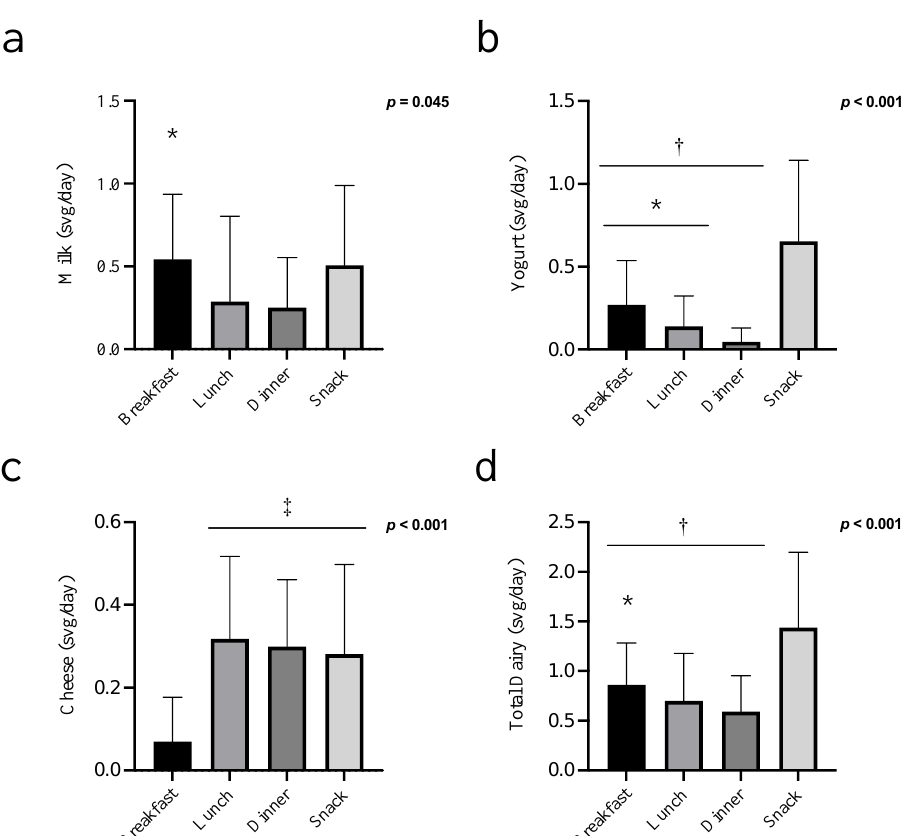
Figure 2. Dairy product consumption patterns in adolescent females in the recommended dairy product intake (RDa) group. Average number of svg/d of milk ( a ), yogurt ( b ), cheese ( c ), and total dairy ( d ) at different eating occasions in the week 12. Data are presented as mean ± standard deviation. F-test p -values are presented from the repeated measure ANOVAs ( p ≤ 0.05 presented in bold). Symbols denote a significant difference from dinner (* p ≤ 0.05), snack († p ≤ 0.05), and breakfast (‡ p ≤ 0.05). Analyses were run with square-root-transformed data sets for milk, yogurt, and cheese and an outlier-treated data set for total dairy.